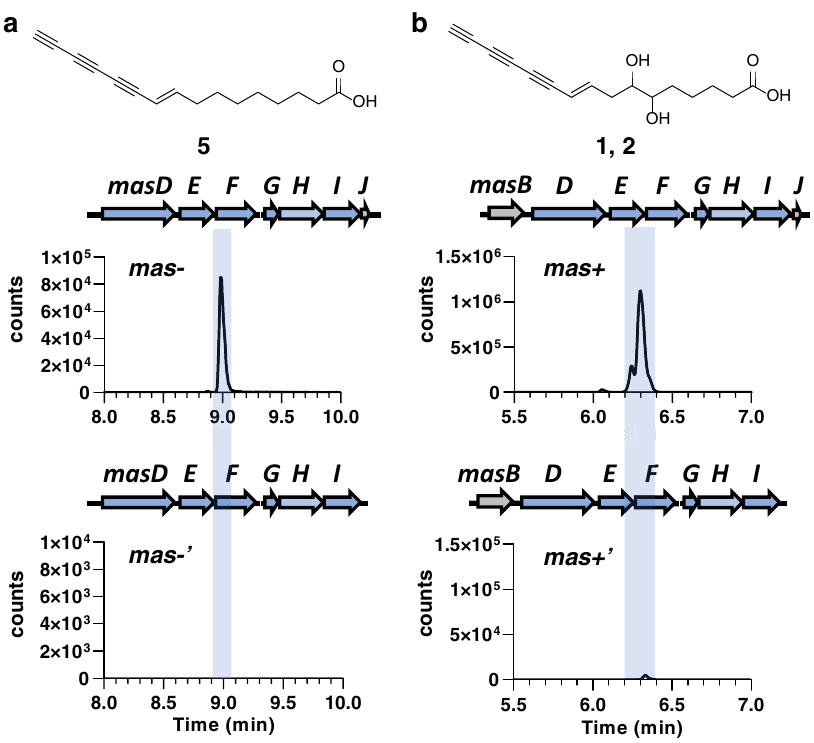
Fig. 2 Heterologous co-expression of mas genes in E. coli . a The EIC ( m/z 241.1234) of engineered E. coli strain, which carried masD , masE , masF , masG , Bv4687 (homolog of masH from Burkholderia vietnamiensis LMG 10929) and masI when co-expressed with ( mas – , top) or without ( mas – ', bottom) masJ . b The EIC ( m/z 273.1132) of E. coli strain mas – and mas – ' harboring additional dioxygenase ( masB ) were renamed as mas + and mas + '. The structures of products are illustrated on top of each chromatogram and were veri fi ed by LC-HRMS/MS analysis (Supplementary Fig.